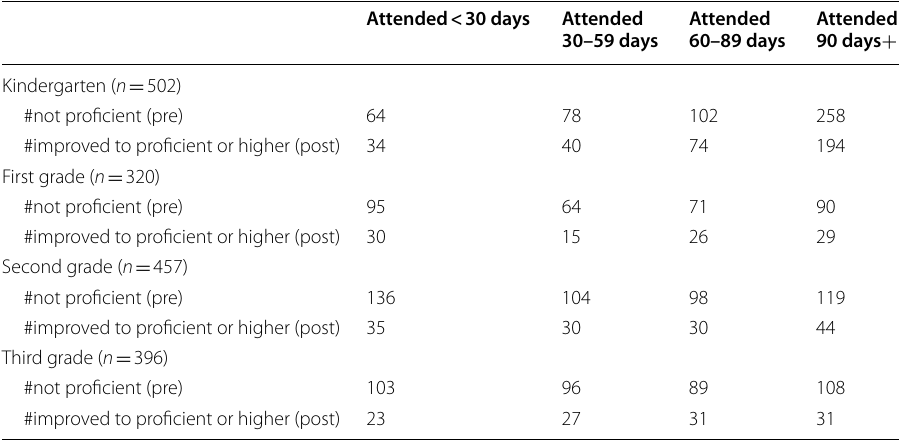
Table 4 Attendance and academic achievement for students K-3 participating in 21st CCLC programs (total n =